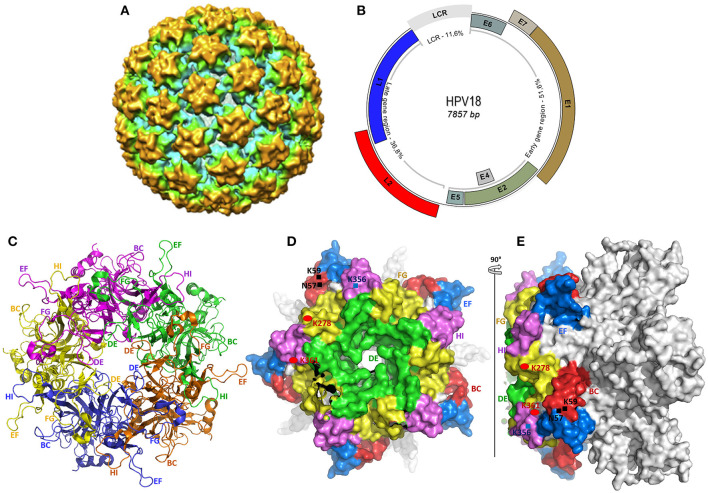
Structural representation of HPV and the L1 protein used as antigen in current vaccines. (A) The cryo-electron microscopy reconstitution of a whole HPV 18 viral particle, solved to a final resolution of 19 Å (82). (B) The viral genome representation of α-HPV (HPV18), constructed from the complete genome sequence of HPV18 (GenBank accession number NC_001357.1). All early and late ORFs, and the long control repeat (LCR) are shown in the respective proportions. (C–E) The crystal structure of HPV18 L1 pentamer, drawn from the PDB ID 2r5i, using PyMol (http://www.pymol.org/funding.html). (C) shows the top core structure of each L1 monomer in the capsomer in different colors revealing the surface loops serving as epitopes for neutralizing antibodies in VLP-based vaccines. (D,E) show the surface conformation in different views (top and side view), revealing each loop in different colors and some specific heparan-sulfate proteoglycan (HSPG) binding sites rich in lysine (K). Both variable and constant regions are clearly seen. The BC loop (49–66), DE loop (111–155), EF loop (169–190), FG loop (262–291), and HI loop (348–361) are clearly represented in (C–E).